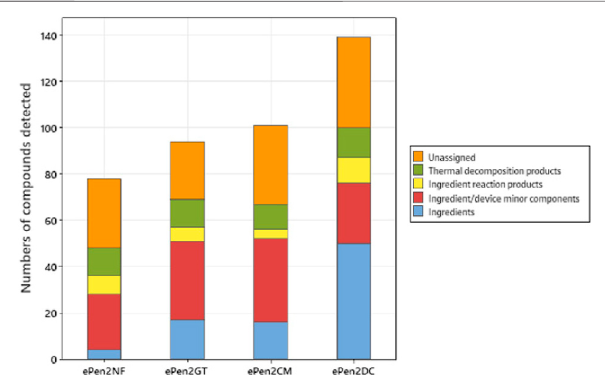
FIGURE 2 | Assigned sources of aerosol compounds from the four e-cigarette variants. The components are assigned to ingredients, minor components of ingredients or device, reaction products, thermal decomposition products, and compounds whose sources could not be